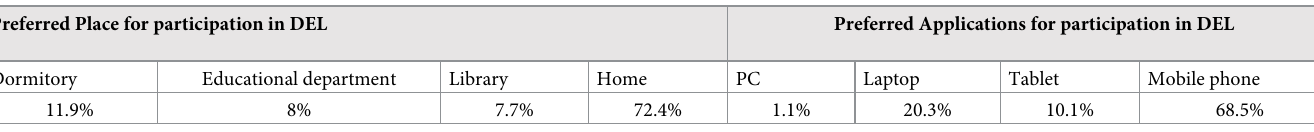
Table 1. Preferred eLearning tools and place for